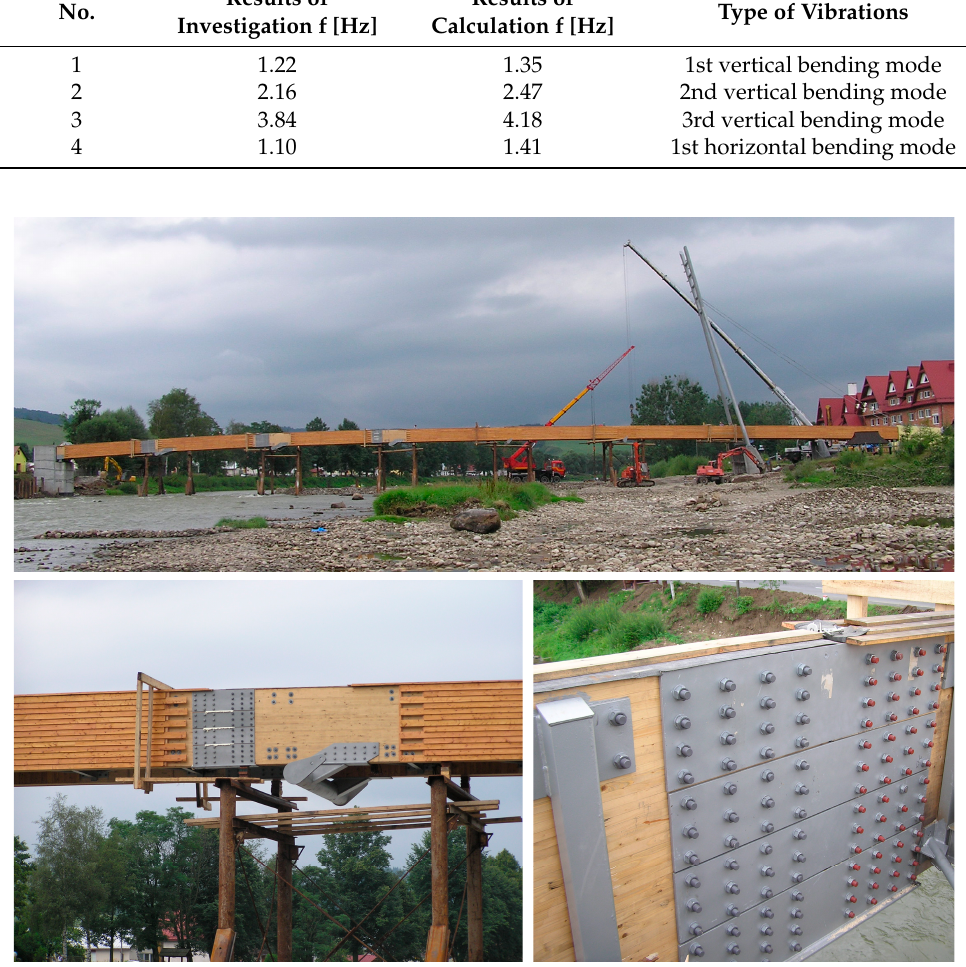
Figure 12. Installation of the deck on the temporary supports and assembling joints in the wooden girders.